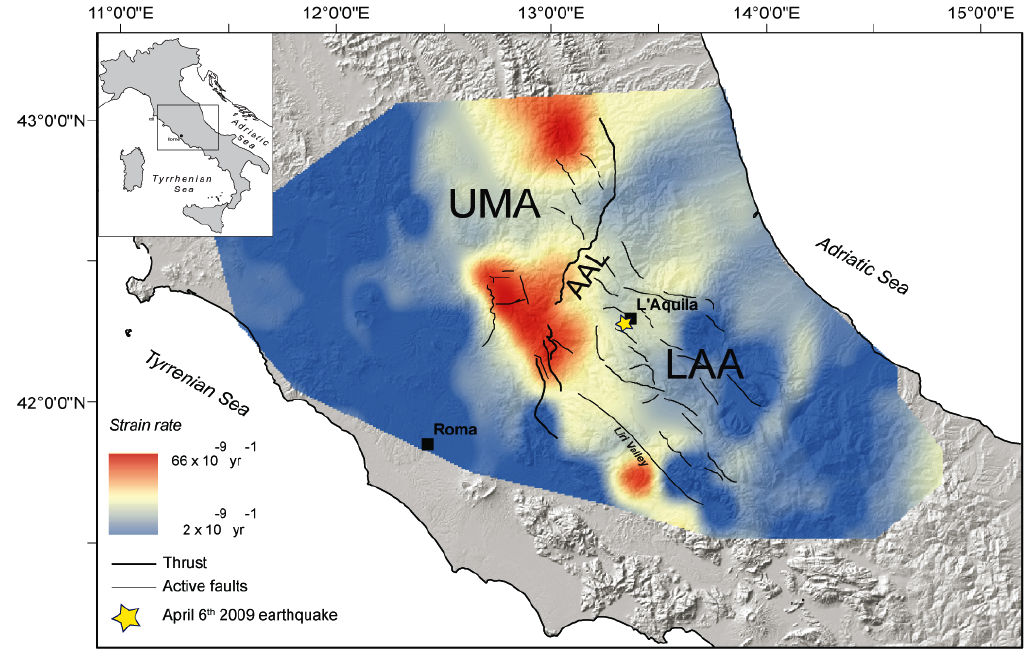
Figure 6. The second invariant estimated on a 0.1° × 0.1° regular grid, according to the algorithm of Shen et al. [1996]. AAL, Ancona Anzio Line; UMA, Umbria-Marche Apennines; LAA, Lazio-Abruzzo Apennines. Inset: Location of the study region within